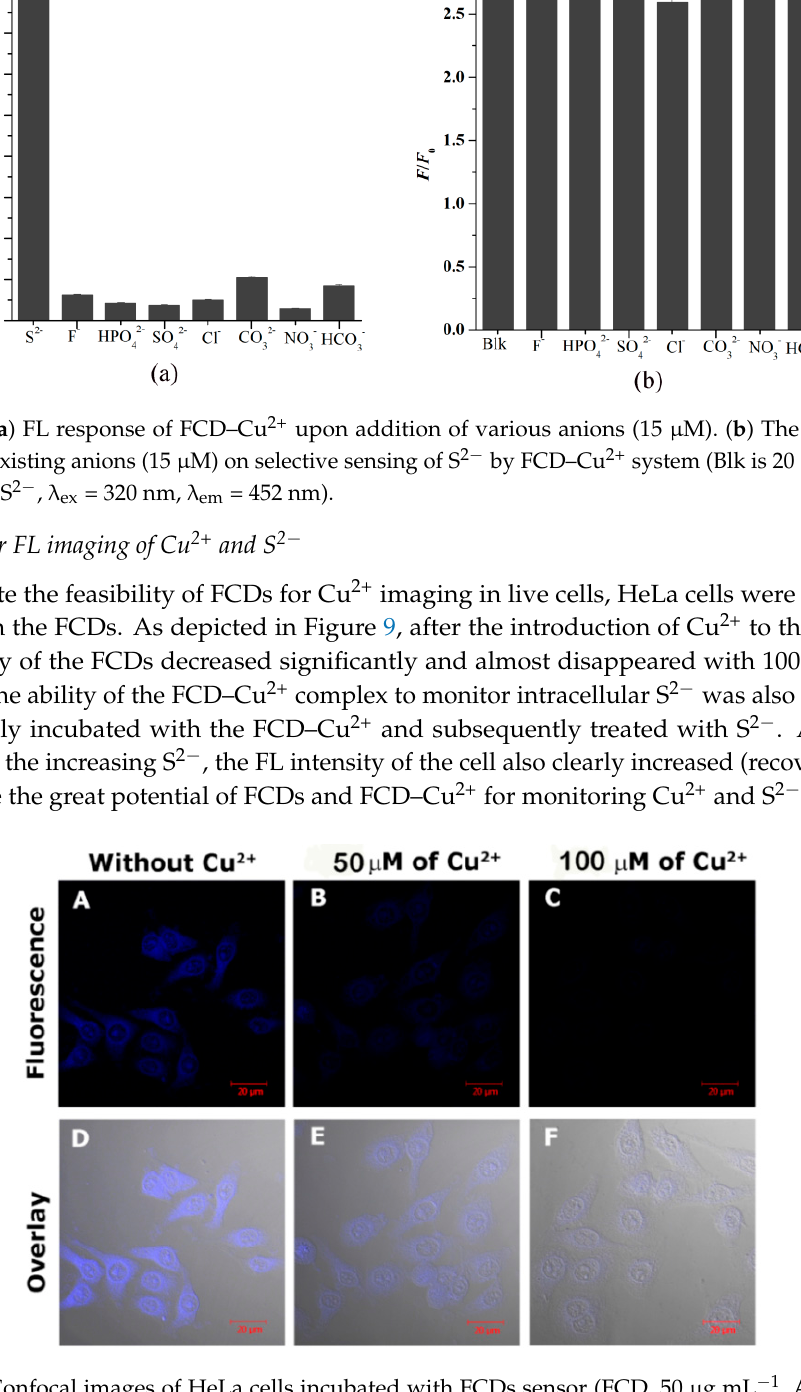
Figure 8. ( a ) FL response of FCD–Cu 2+ upon addition of various anions (15 μ M). ( b ) The effect of and 15 μ M S 2 − , λ ex = 320 nm, λ em = 452 nm).